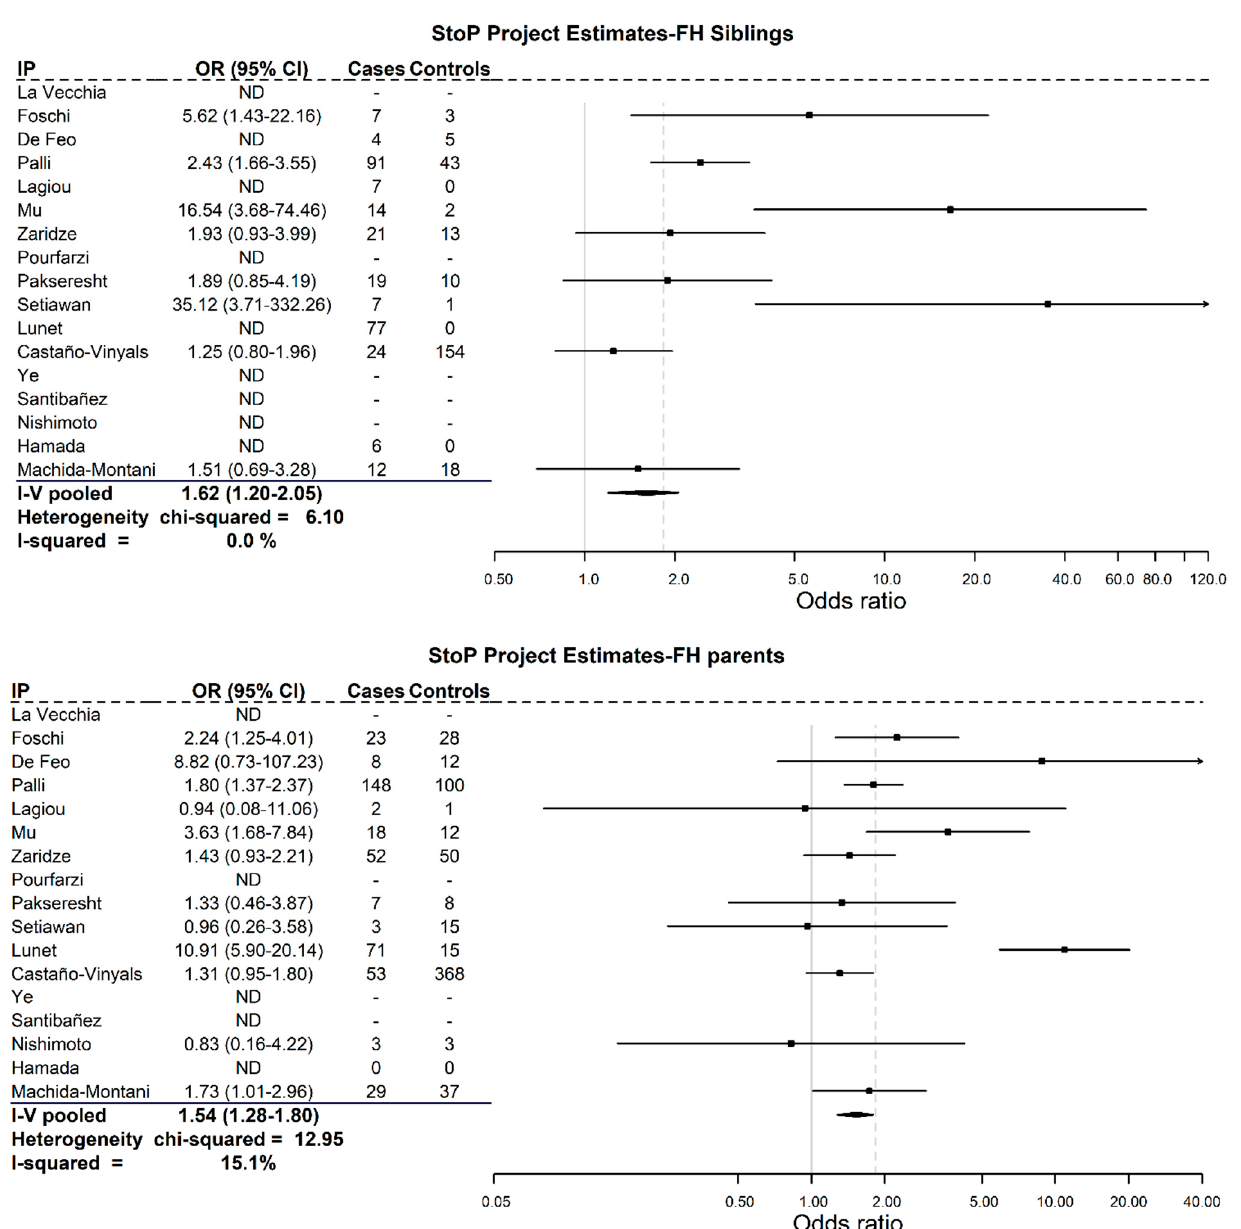
Figure 2. Pooled adjusted odds ratios with 95% confidence intervals considering the type of relative affected.